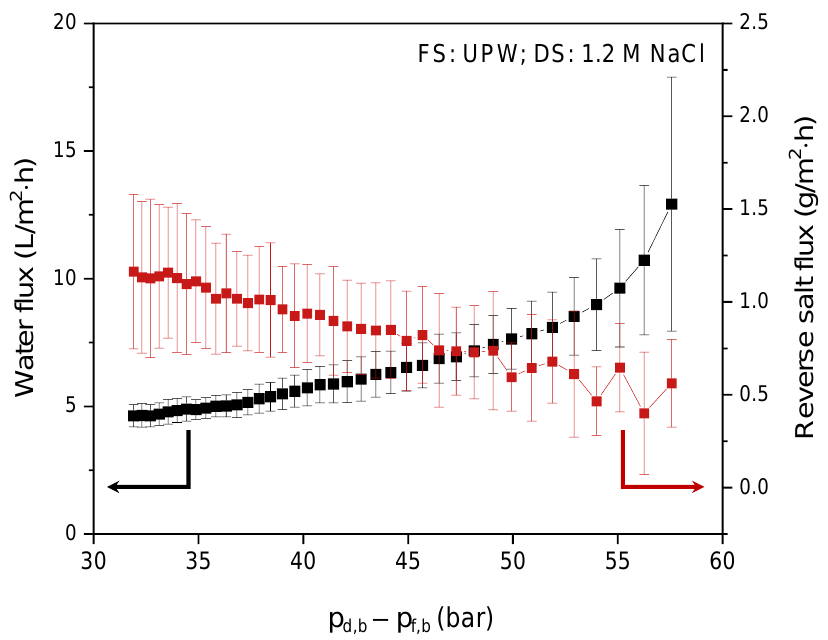
Figure 6. Membrane performance using a 1.2 M NaCl solution DS and UPW as FS: water flux and reverse salt flux as a function of the osmotic pressure difference over the membrane between bulk DS and bulk FS. Average values calculated based on five separate runs.